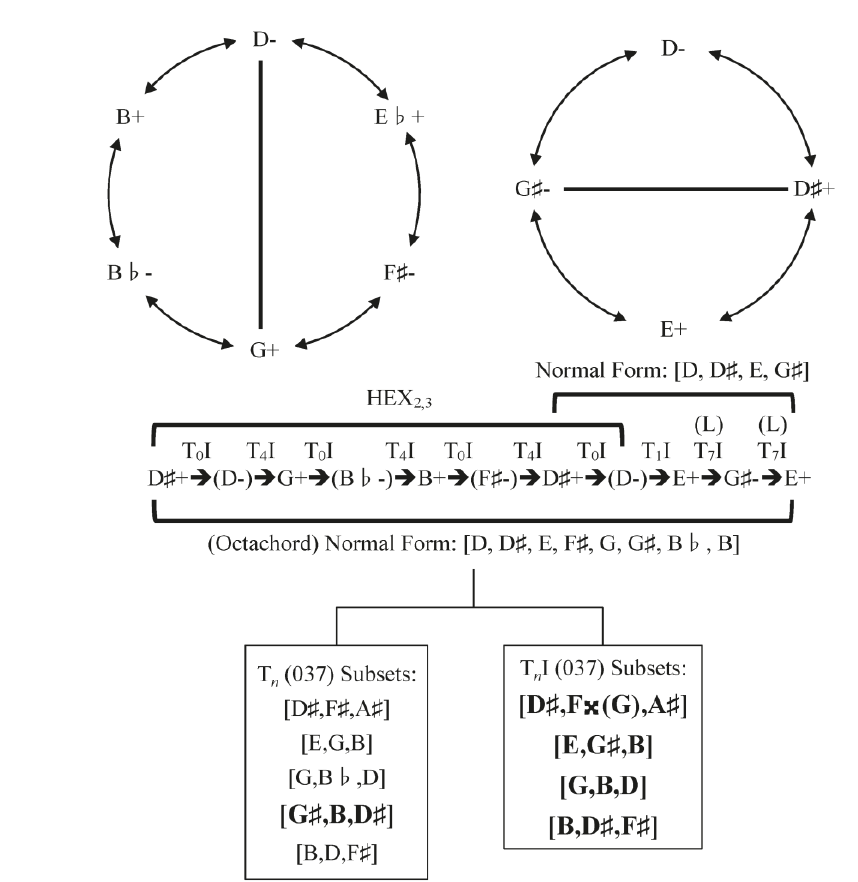
Figure 5. Macklay (2014) Many Many Cadences ; ( a ) six measures before section A1 and ( b ) theoretical abstraction. Please note that M.S.P. in the score stands for molto sul ponticello. Although Tymoczko (2008a) defines triadic transformations (e.g.,